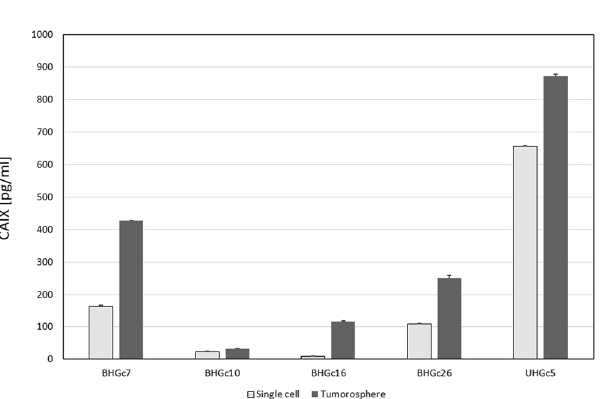
Figure 4. Growth fractions of SCLC CTCs as determined by Ki67 and PI DNA staining. Percentages of Ki67 and S-phase cells are presented as mean ± SD. All differences between the S-phase fractions as determined by Ki67 high and the PI flow cytometric method are statistically significant.